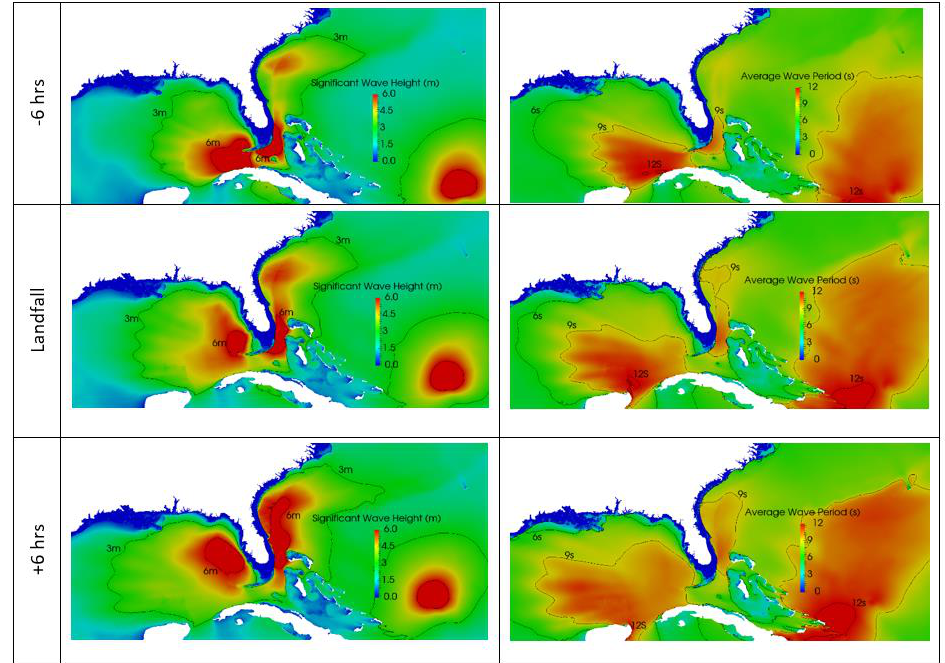
Figure 3. Snapshots of wave fields for Hurricane Irma at select times with respect to landfall. Significant wave height (m) ( Column 1 ); average wave period (s) ( Column 2 ).